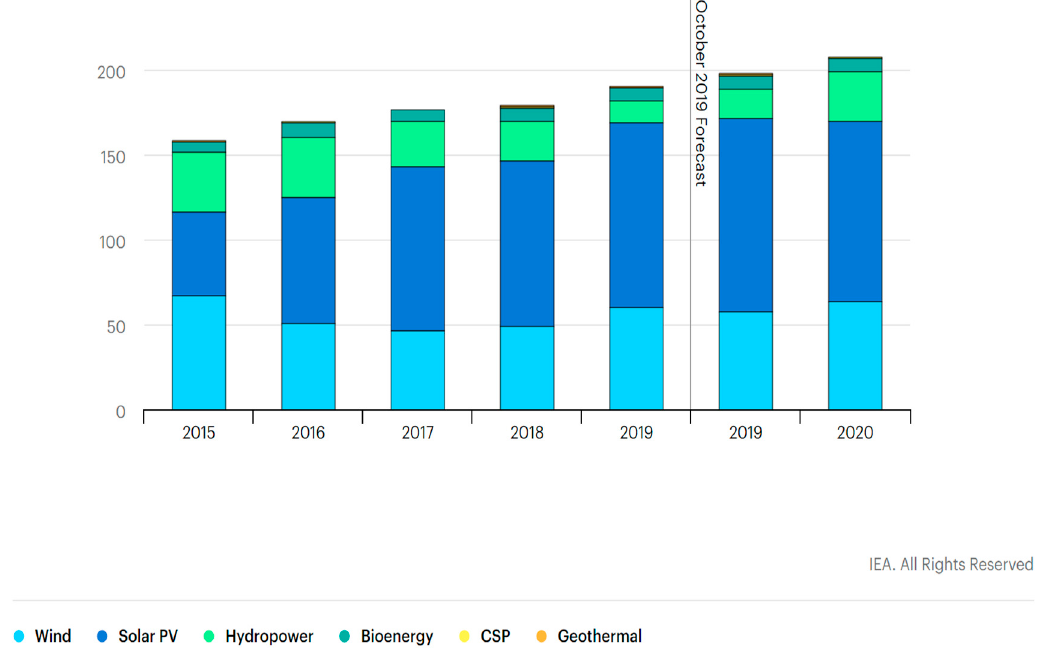
Figure 1. Predicted energy expansion by energy source [14].